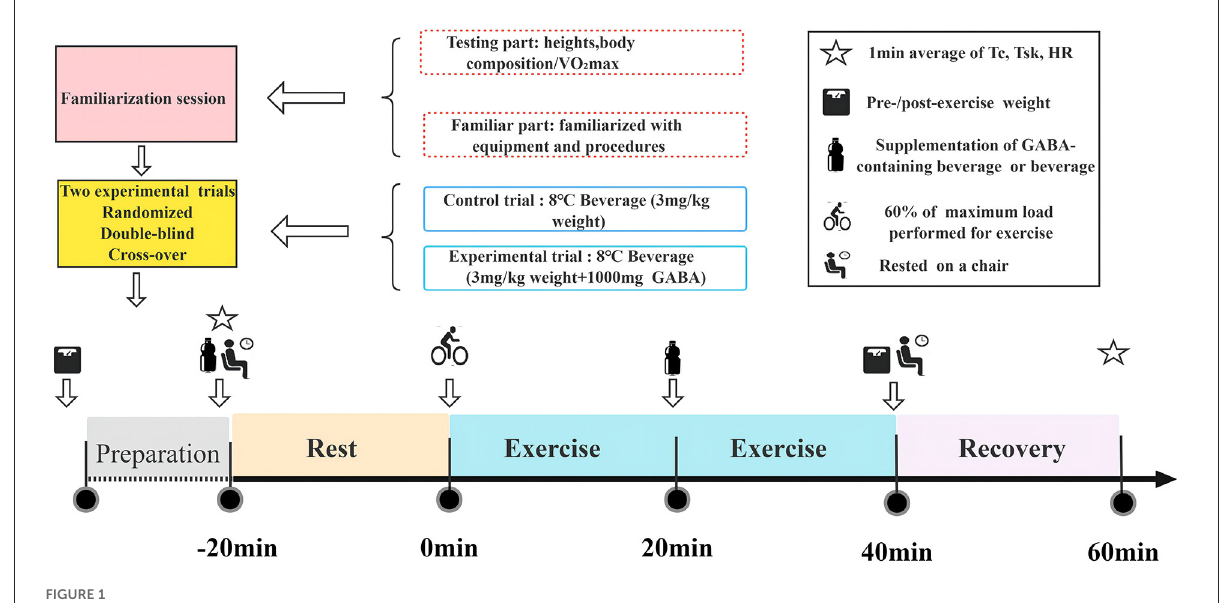
FIGURE1 Flow chart of the whole